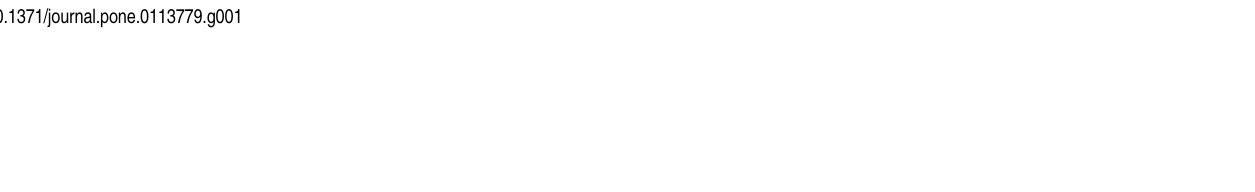
PLOS ONE | DOI:10.1371/journal.pone.0113779 December 5,